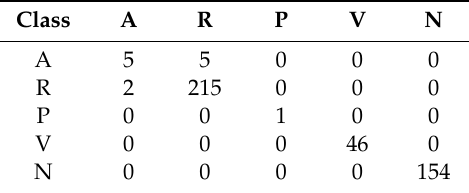
Table 6. Confusion matrix in the testing phase.